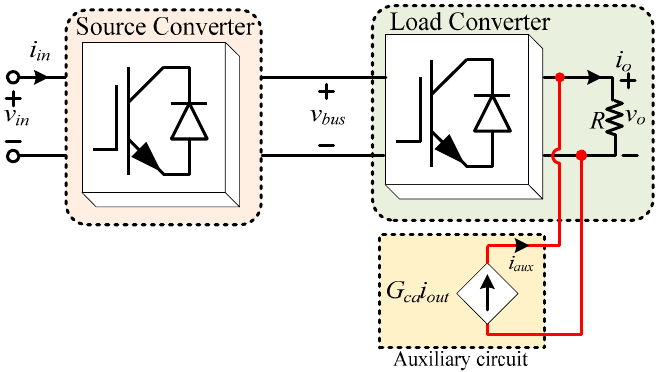
Figure 16. Intermediate-level active damping by adding an adaptive active capacitor converter (AACC) [103].